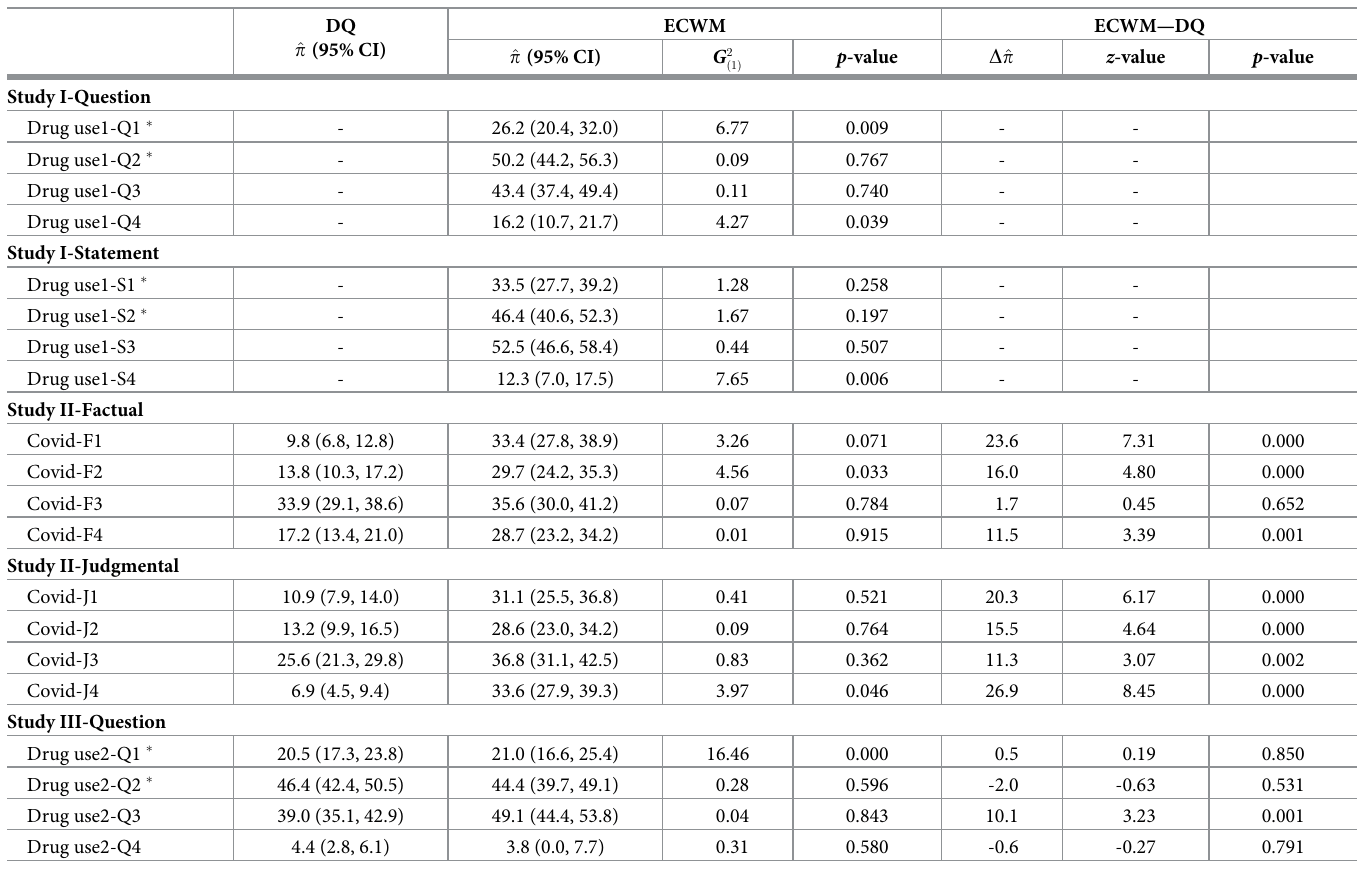
Table 2. Prevalence estimates of Studies I, II, and III.